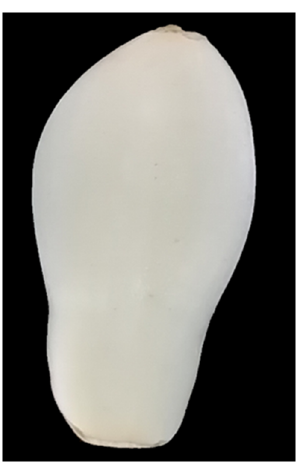
Figure A1. Reference scale.